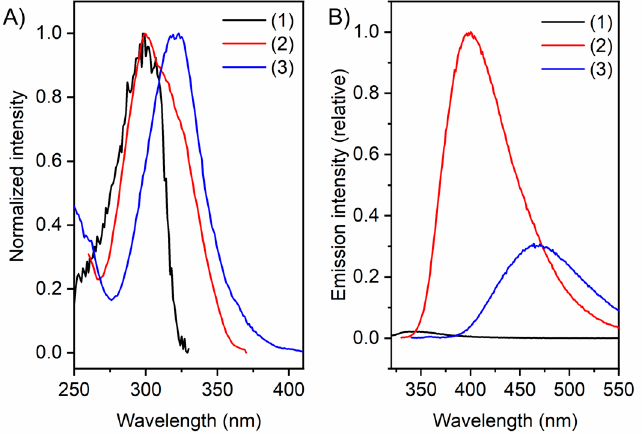
Figure 4. ( A ) Normalised excitation spectra of ( 1 ), ( 2 ) and ( 3 ). ( B ) Emission spectra of ( 1 ), ( 2 ) and ( 3 ) excited at corresponding excitation wavelength. Conditions: Concentration = 10 µM in bis-tris buffer 6 mM, pH = 6.